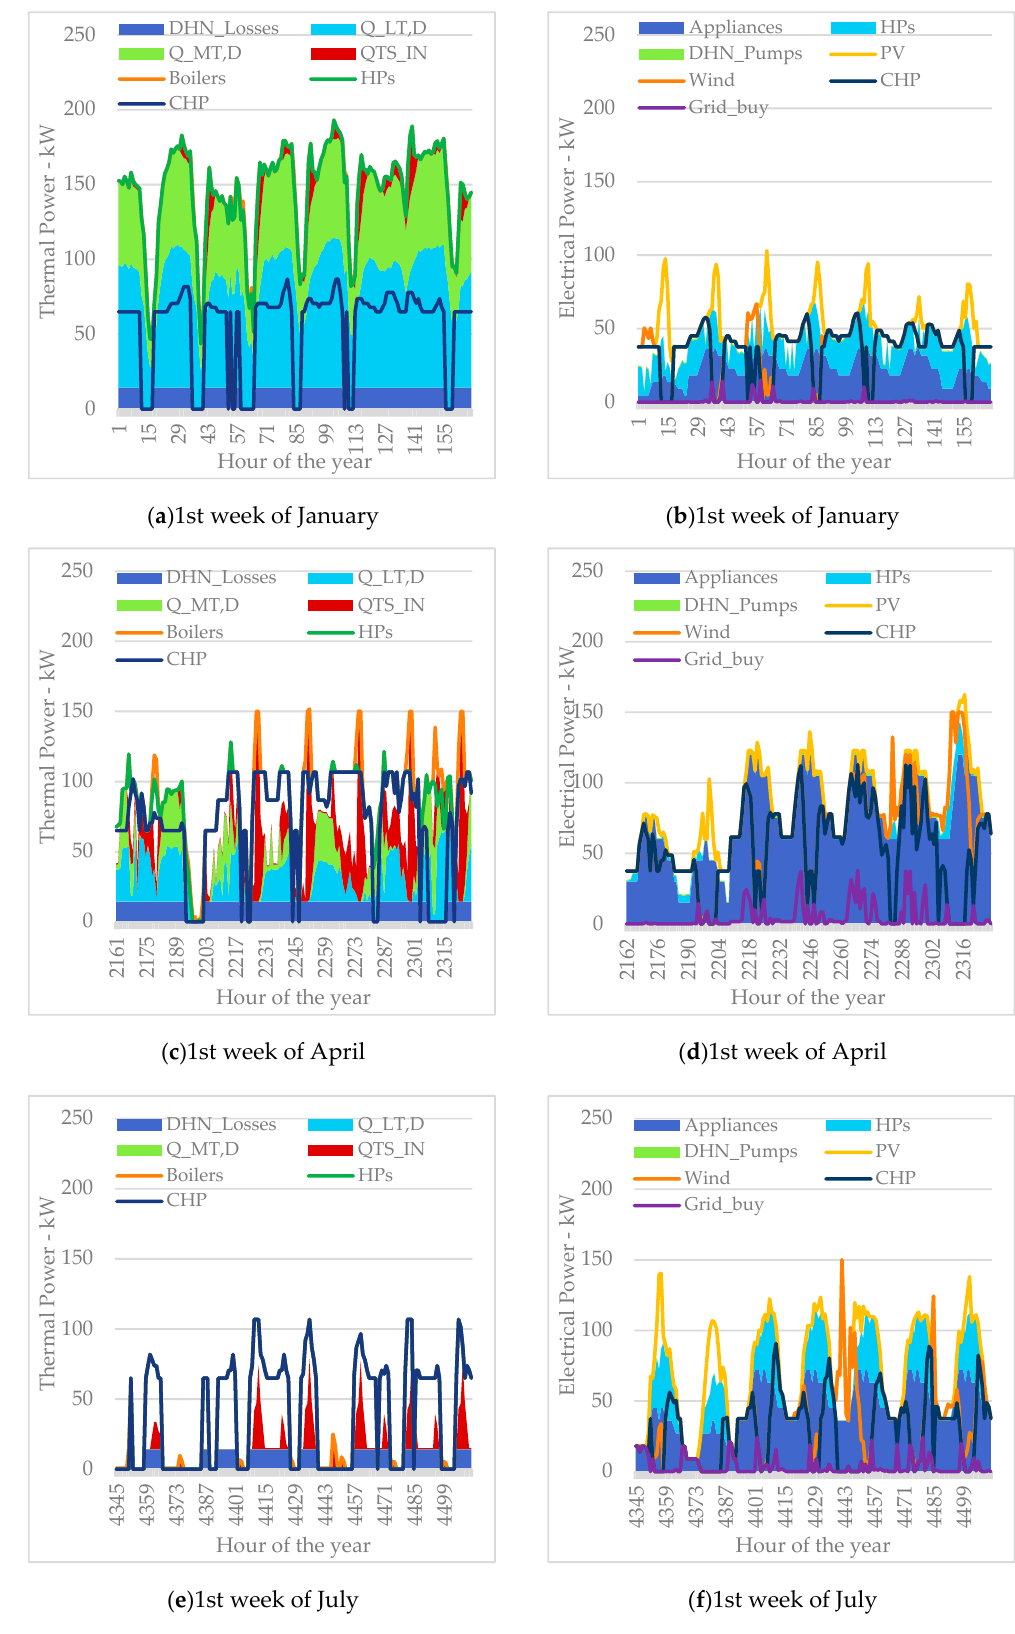
Figure 6. Heat and power profiles in 3 weeks of the year (areas are for consumption, lines for production).